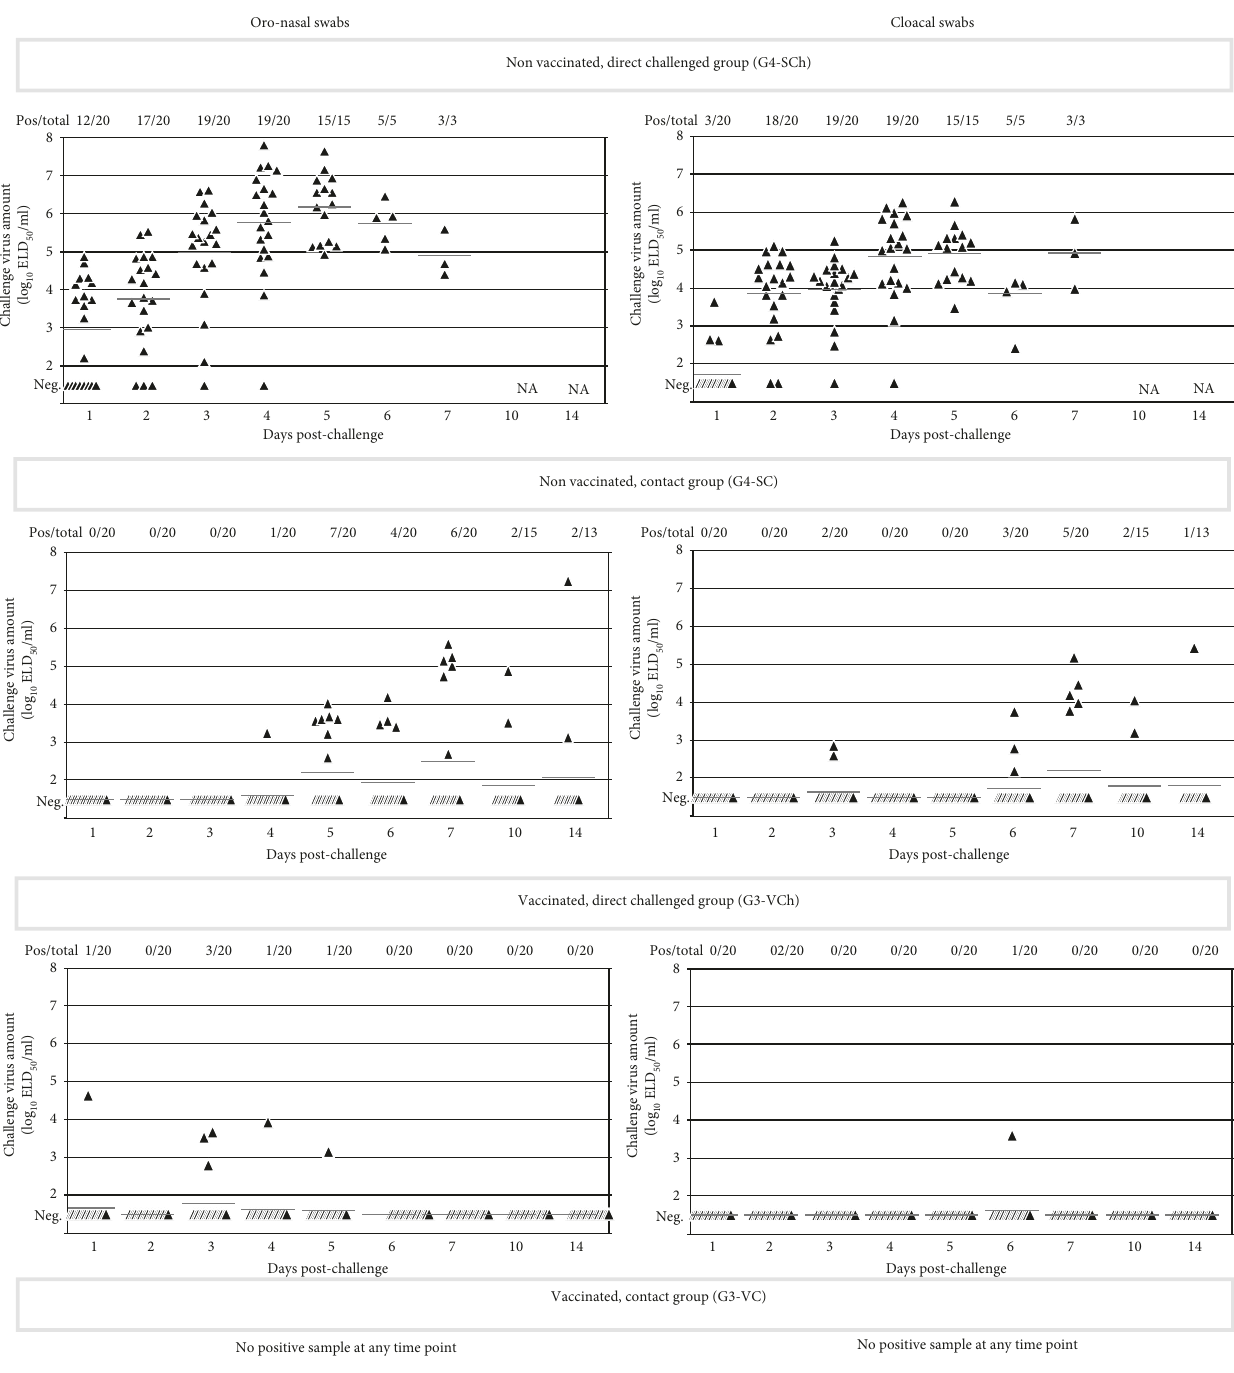
Figure 6: Oronasal and cloacal shedding by layers. AIV load of swab samples measured by qRRT-PCR is presented as log scatterplot; horizontal bars represent group mean value for each date. For calculation of mean, negative samples were given a value of 1.5 log ELD /ml. Contact challenged groups (G3-VC and G4-SC) were comingled with the direct-challenged groups (G3-VCh and G4-SCh) from 8 50 hours postchallenge. Sampling date refers to the time after direct